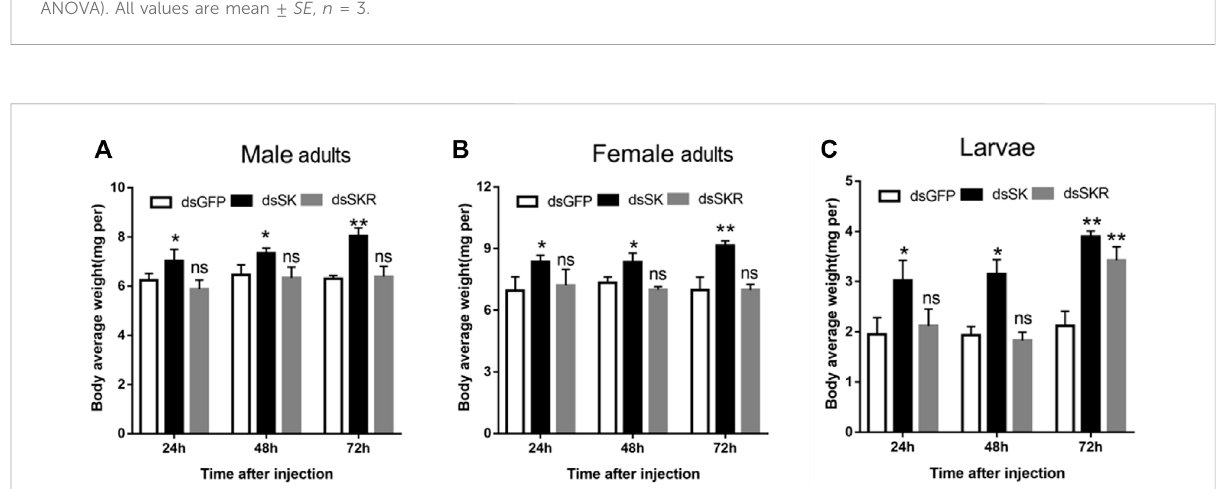
asterisk indicates a signi fi cant difference between dsRNA treatment group and the control group (* p < 0.05, ** p < 0.01, and *** p < 0.001, one-way ANOVA). All values are mean ± SE , n = 3.